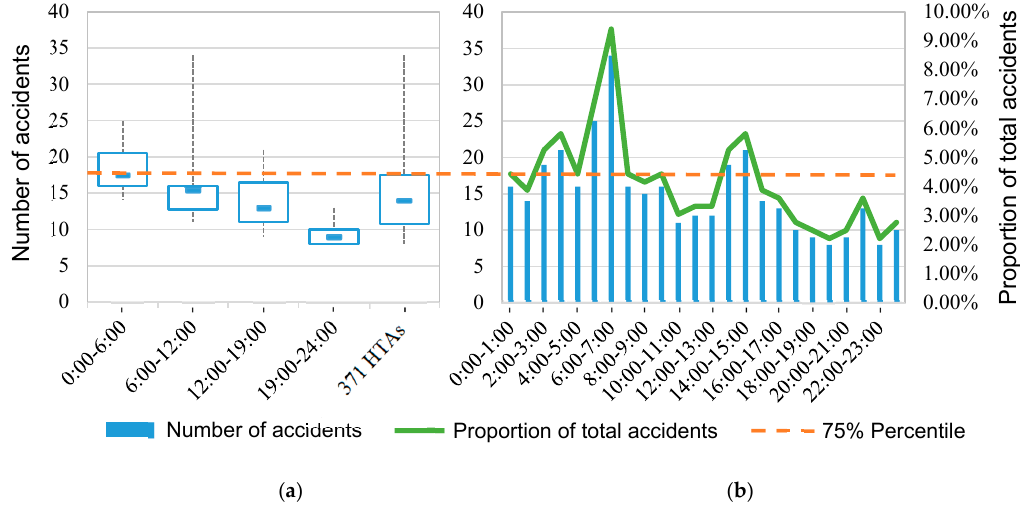
Figure 5. Temporal distribution of the 371 HTAs. The number of accidents is counted according to the time period. ( a ) describes the upper quartile, the lower quartile, and the median of the accident number for the four periods and the full sample. In Figure ( b ), the bars show the number of accidents in each hour, and the green line presents the corresponding proportion of the total 371 HTAs. The dotted line is the 75% quartile of accidents for the full sample, with a value of 17.5.